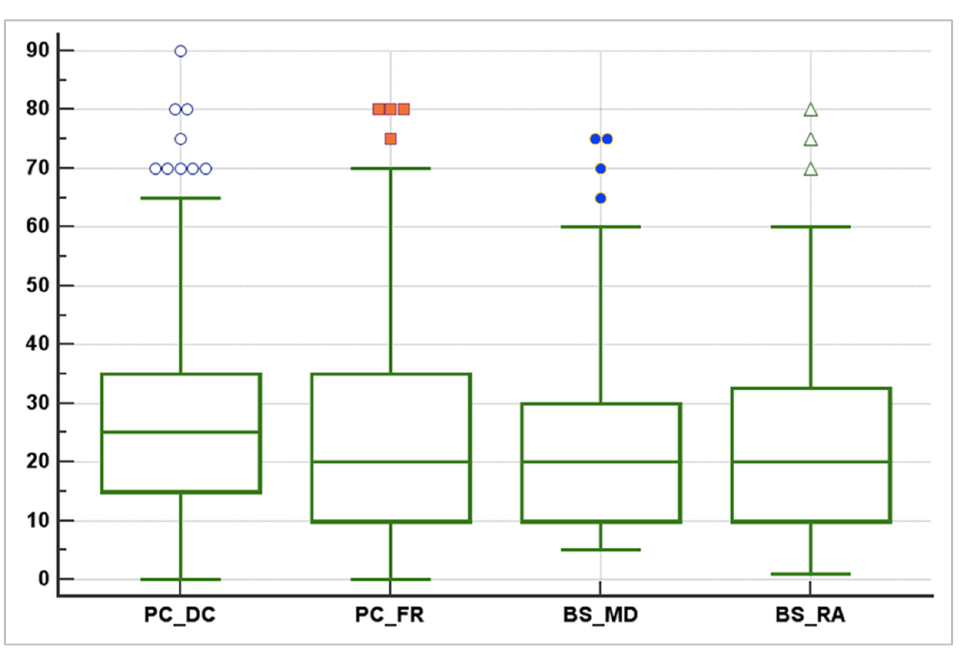
Figure 9. The descriptive statistics from the radiologists’ measurements. The agreement between radiologists for visual estimation of pneumonia from CT was good, as shown in this box, plot scheme (ICC 0.79, 95% CI 0.73–0.84). Only one radiologist esteemed a higher visual score (considered as the median). ICC = Intraclass Correlation Coefficient, CI = Confidence Interval. Table 2. Summary of descriptive statistical calculation obtained from the four radiologists. This table shows good reliability among the four radiologists, as underlined by the good ICC score (0.79). ICC = Intraclass Correlation Coefficient. 25th Percentile Median 75th Percentile 1° radiologist (D.C.)